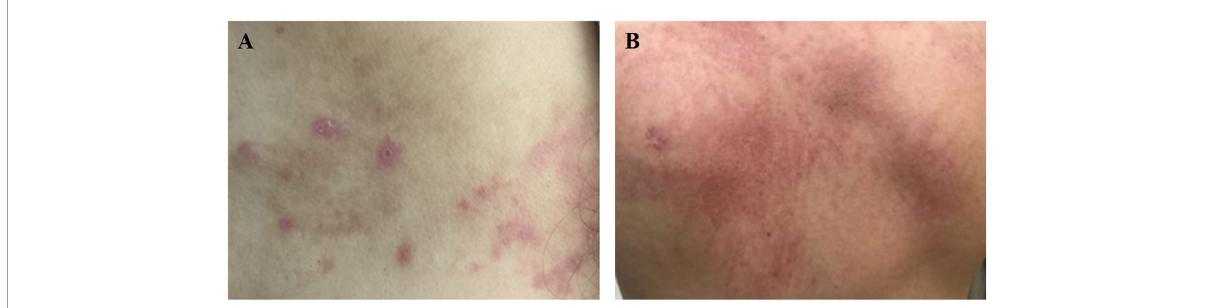
FIGURE1 (A) Salmon-pink evanescent skin eruptions (ESEs) is which always accompanied by fever. (B) Dark red atypical persistent skin eruptions (APSEs), which is usually presented as linear or scratch-like